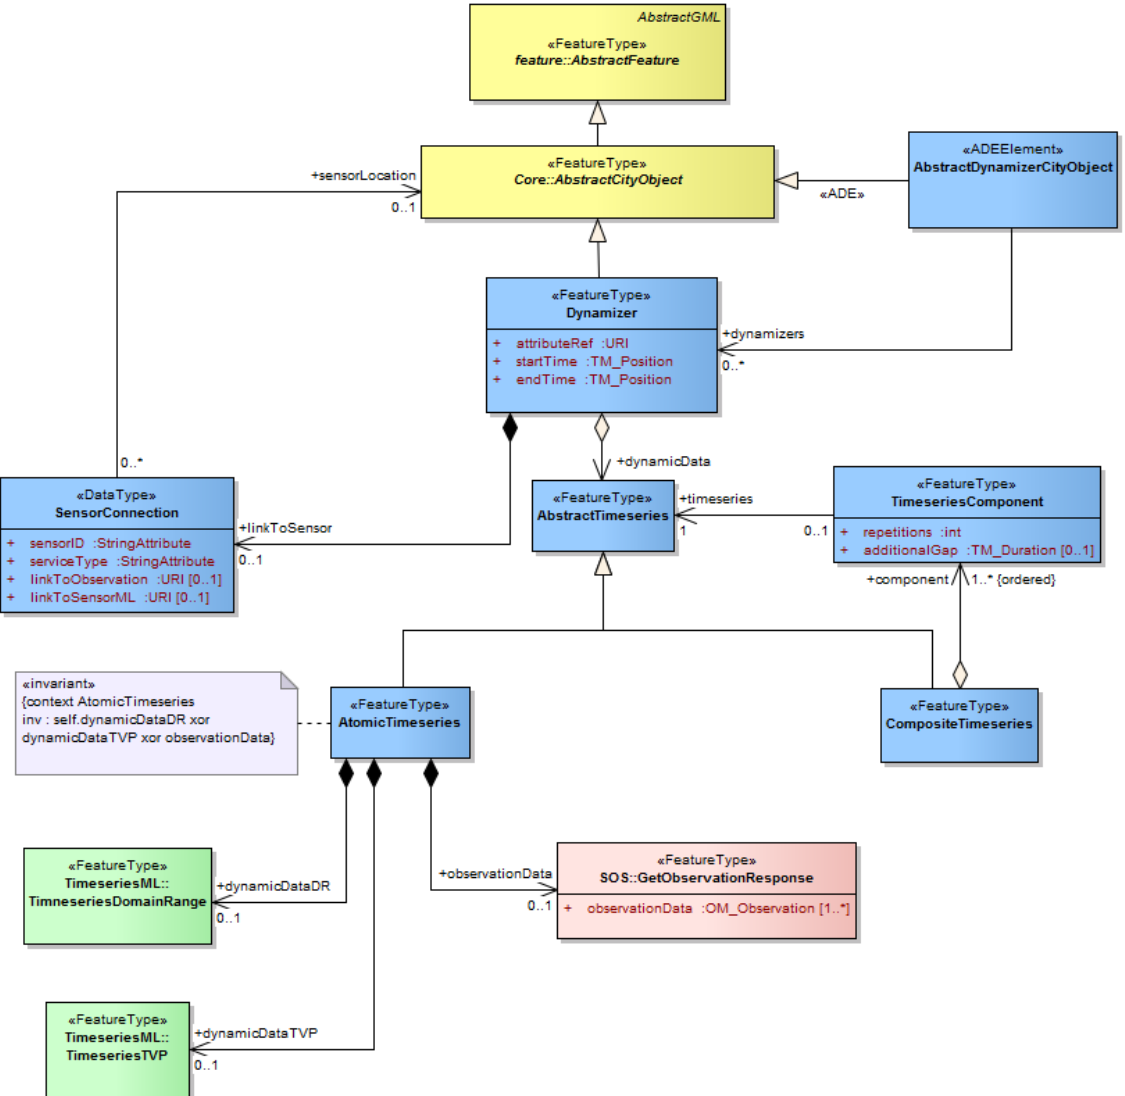
Figure 4. Dynamizer defined as UML model. Newly introduced classes are shown in blue. Classes shown in green and pink represent TimeseriesML 1.0 and Sensor Observation Service. Classes shown in yellow are from GML and CityGML